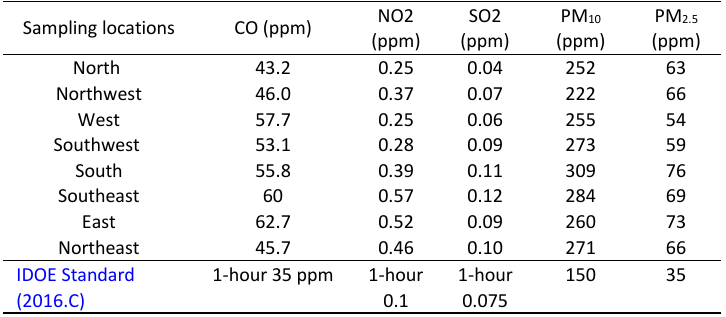
Table 4: Results of measuring air pollutants over Tehran West Terminal on April 17, 2017 between 7-10 a.m.